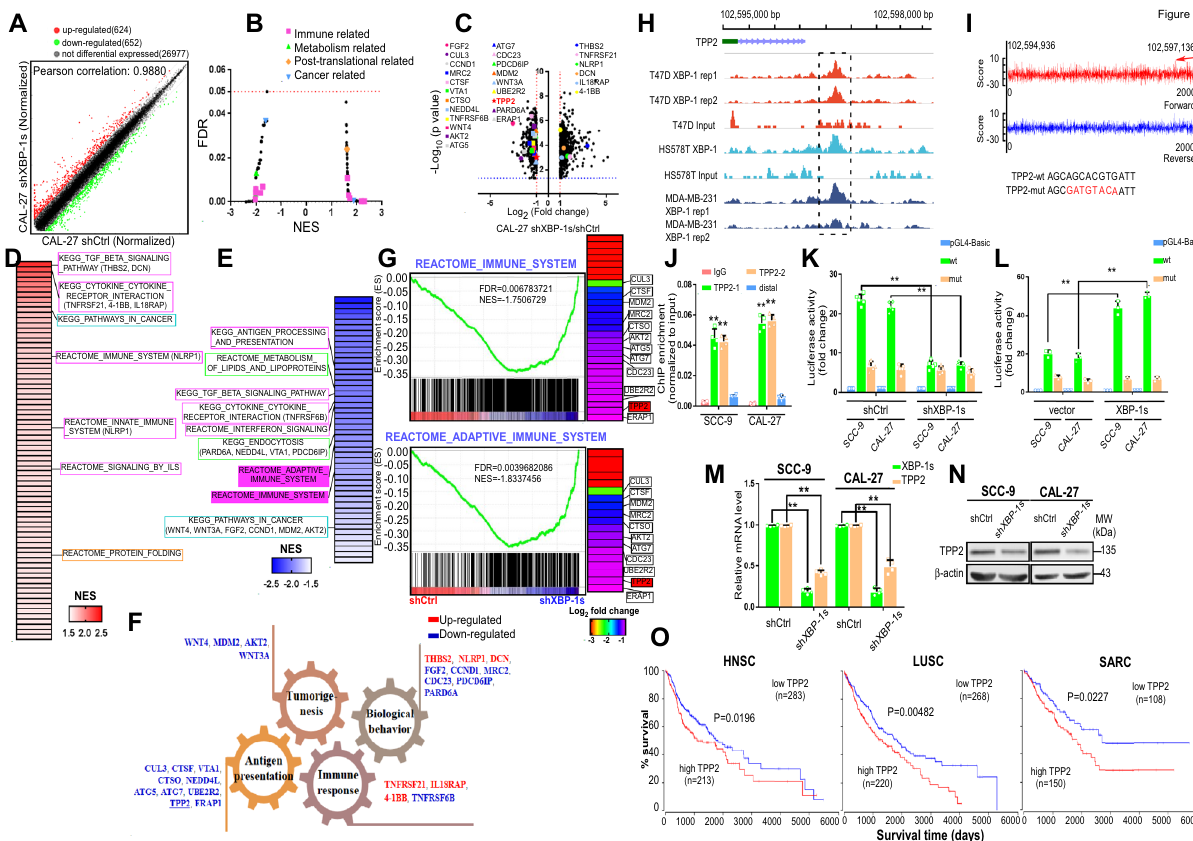
Fig. 6 Bioinformatic analysis based on mRNA pro fi le indicated TPP2 as the potential target of XBP-1s. A Scatter plot of relative mRNA expression in CAL-27 treated with shXBP-1s compared with negative control. Genes in green and red are differentially expressed at signi fi cant levels ( n = 3 per group). B GSEA (KEGG, REACTOME, and BIOCARTA) pathway distribution for shXBP-1s versus negative control of CAL-27. Horizontal line denotes FDR signi fi cance cutoff of 0.05. Immune-, metabolism-, post-translation- and cancer-related gene sets were demarcated by dots in indicated colors, respectively. C Volcano plot of differentially expressed genes on the basis of fold change and p value. Genes to be focused on were labeled. D Gene sets upregulated in shXBP-1s CAL-27 compared to the negative control (FDR < 0.05 and NES > 1.5). Color gradation is based on GSEA NES. Gene sets demarcated in panel ( C ) were speci fi ed. E Gene sets downregulated in shXBP-1s compared to negative control of CAL-27 (FDR < 0.05 and NES < − 1.5). Color gradation is based on GSEA NES. Gene sets demarcated in panel ( C ) were speci fi ed. Gene sets containing TPP2 were highlighted. NES indicates normalized enrichment score. F Diagrammatic drawing of associated genes divided into four groups based on respective functions that are recognized in cancer biology. G Downregulated genes from the two gene sets. Color gradation is representative of log2 fold change over negative control. Relevant genes were labeled and TPP2 was labeled in red. shCtrl indicates negative control. H Distribution of XBP-1 occupancy frequencies in TPP2 promoter in three different cancer cell lines based on ChIP-seq database, respectively. The most enriched peaks are highlighted. I Motif analysis (motif-counter) showed the enriched XBP-1 motif in TPP2 promoter, the arrow indicates that the highest score binding sites consistently located in the forward strand, which was highlighted in panel ( H ). J ChIP-qPCR analysis of the XBP-1 genomic occupancy in the TPP2 promoter in SCC-9 and CAL-27 as indicated. Immunoprecipitated DNA was measured by qRT-PCR with primers to amplify the TPP2 promoter region, including the distal site (mean ± s.e.m; n = 4; p < 0.0001, p < 0.0001, p = 0.3961 for SCC-9 and p < 0.0001, p < 0.0001, p = 0.408 for CAL-27; ** p < 0.001 by one-way ANOVA followed by Dunnett ’ s tests for multiple comparisons). K Luciferase assay demonstrated that knockdown of XBP-1 inhibited TPP2 promoter ’ s activity in SCC-9 and CAL-27. SCC- 9 and CAL-27 cells with stable expression of wild-type (wt) or mutant (mut) TPP2 promoter delivered pGL4.20-Basic vectors were co-transfected with shXBP-1 or shCtrl (mean ± s.e.m; n = 5; p < 0.0001 for SCC-9 and CAL-27; ** p < 0.001 by one-way ANOVA followed by Dunnett ’ s tests for multiple comparisons). L Luciferase reporter assay demonstrated that XBP-1 activated TPP2 promoter (mean ± s.e.m; n = 3; p < 0.0001 for SCC-9 and CAL-27; ** p < 0.001 by one-way ANOVA followed by Dunnett ’ s tests for multiple comparisons). M qRT-PCR veri fi ed the downregulation of TPP2 from microarrays in TSCCs after XBP-1s knockdown (mean ± s.e.m; n = 4; p < 0.0001 for SCC-9 and CAL-27; ** p < 0.001 by two-tailed t -test). N Immunoblotting further veri fi ed the downregulation of TPP2 in TSCCs after XBP-1s knockdown. MW molecular weight. β -actin, loading control. O Overall survival of cancer patients with different levels of TPP2 using The Cancer Genome Atlas (TCGA) database ( p = 0.0196, 0.00482 and 0.0227) HNSC head and